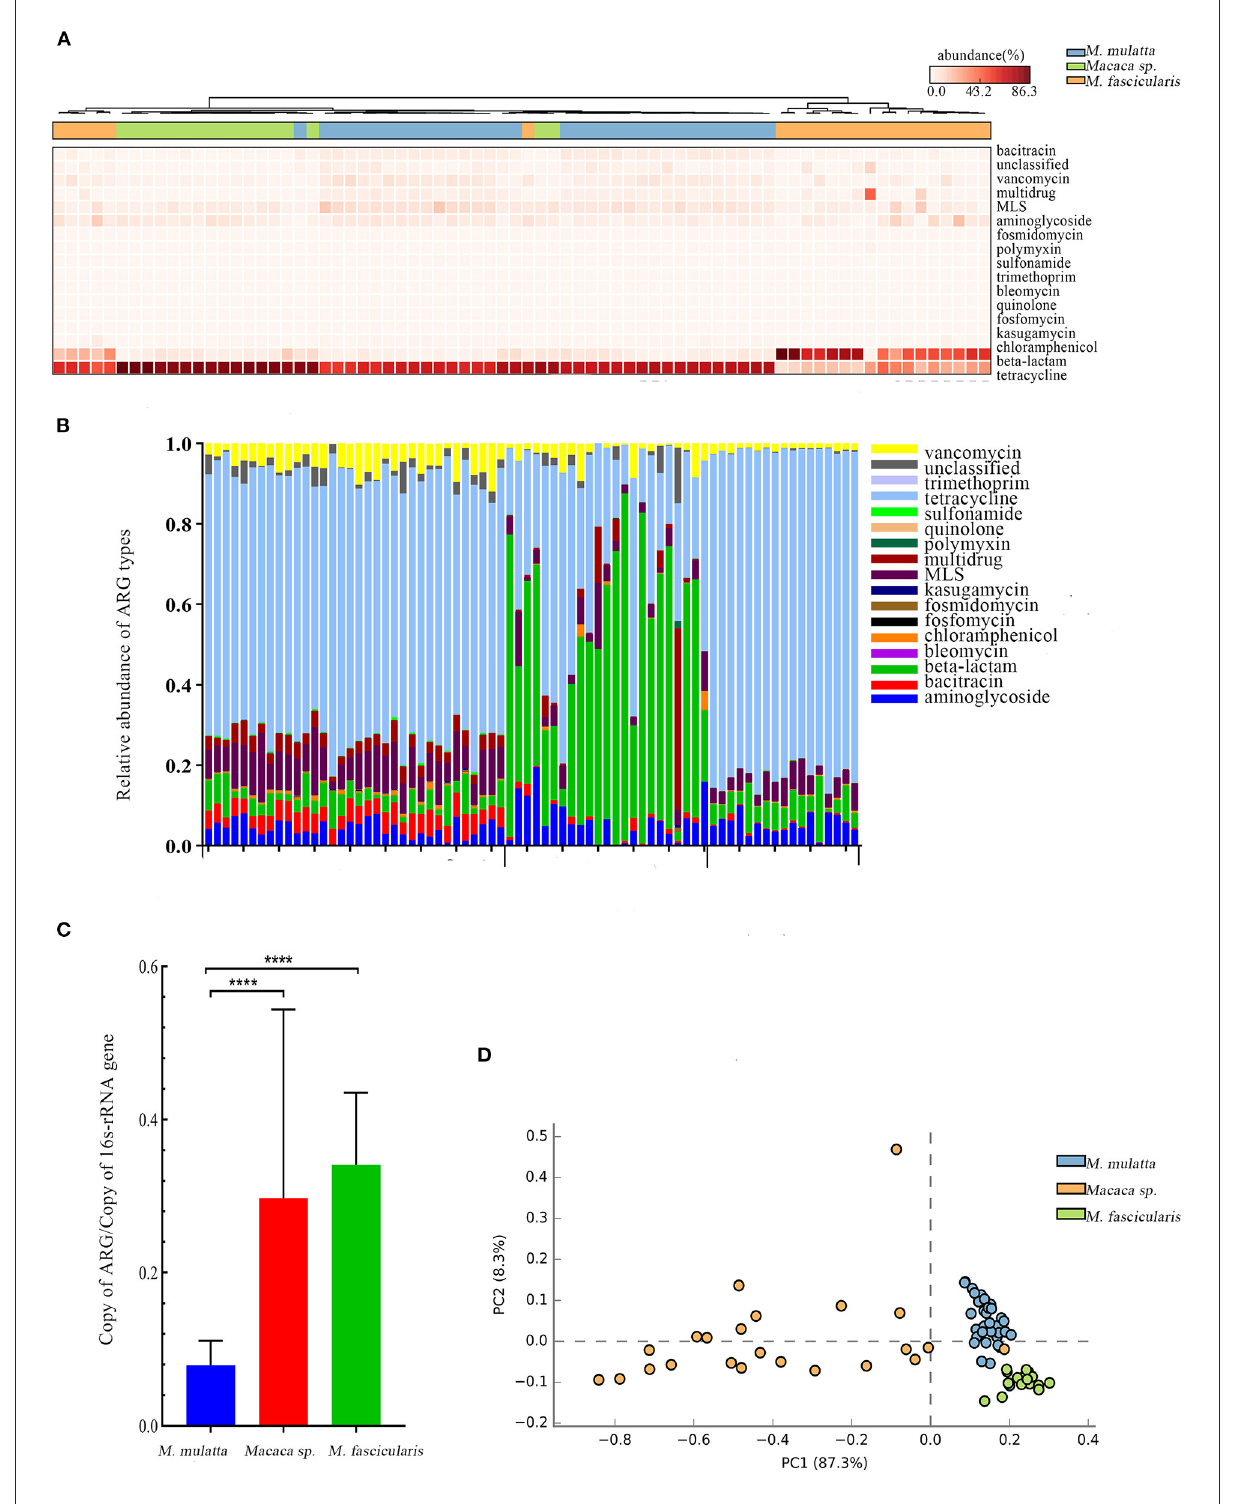
FIGURE3 Comparison of Macaca spp. gut microbiota ARGs from three regions. (A) Heat map clustering 17 antibiotics of 74 samples. (B) Relative abundance of 17 antibiotics of 74 samples. (C) Barplot of total ARG relative abundance of 74 samples ( t -test, **** P < 0.0001). (D) PCA plot of ARG relative abundance of 74